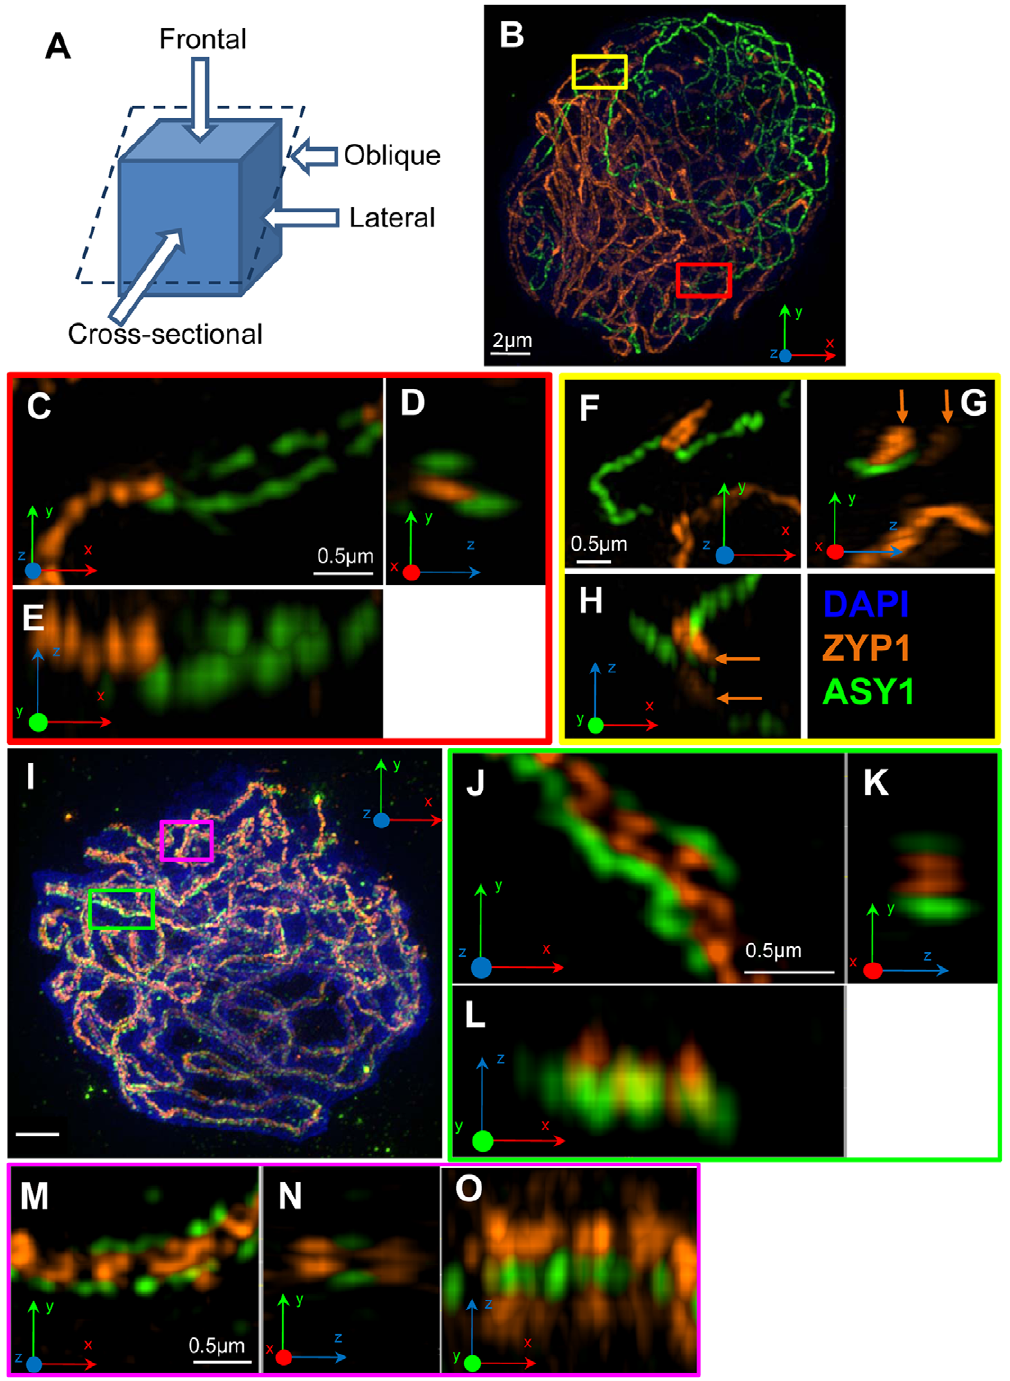
Figure 4. High resolution imaging of barley prophase I nuclei. (A) Diagram illustrating the nomenclature of the various planes of view of the SC, according to Moses (1968). Note that oblique section is defined as any plane of section at an angle to the axis that is not perpendicular. (B) Zygotene nucleus showing ASY1 (green) and ZYP1 (orange) cores, and chromatin (blue). (C–E) Enlargement of the region delimited by the red box in (B) showing the standard SC structure in frontal view (C), cross-sectional view (D) and oblique view (E) where a single ZYP1 structure is visible. (F–H) Enlargement of the region delimited by the yellow box in (B) showing the different SC structure. Frontal view (F), lateral view (G) and oblique view (H) where the two ZYP1 structures are visible (orange arrows) are also shown. (I) Pachytene nucleus showing ASY1 (green) and ZYP1 (orange) cores, and chromatin counterstained with DAPI (blue). (J–L) Enlargement of the synapsed region delimited by the green box in (I) showing the usual SC structure in frontal view (J), cross-sectional view (K) and lateral view (L). (M–O) Enlargement of the synapsed region delimited by the pink box in (I) showing the different SC structure in frontal view (J), cross-sectional view (N) and lateral view (O). All images are maximum projections of nuclei embedded in polyacrylamide and captured by 3D-SIM. The xyz angles shown in each image relate to the orientation of the captured image.